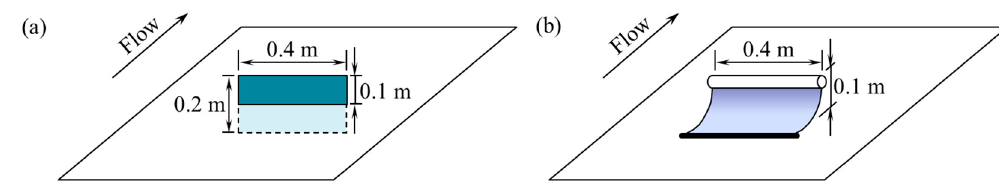
Figure 3. Sketch of two models of flow deflector (not to scale): ( a ) Rigid flow deflector, ( b ) Flexible flow deflector.